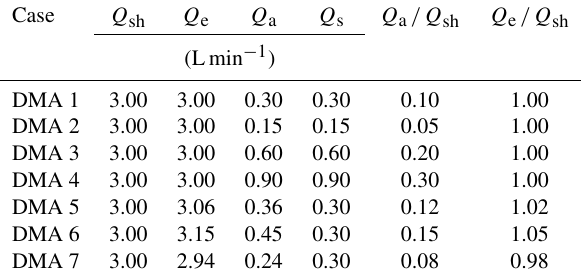
Table 1. Theoretical DMA flow test cases. Table 2. Predicted downstream particle diameter range for each DMA